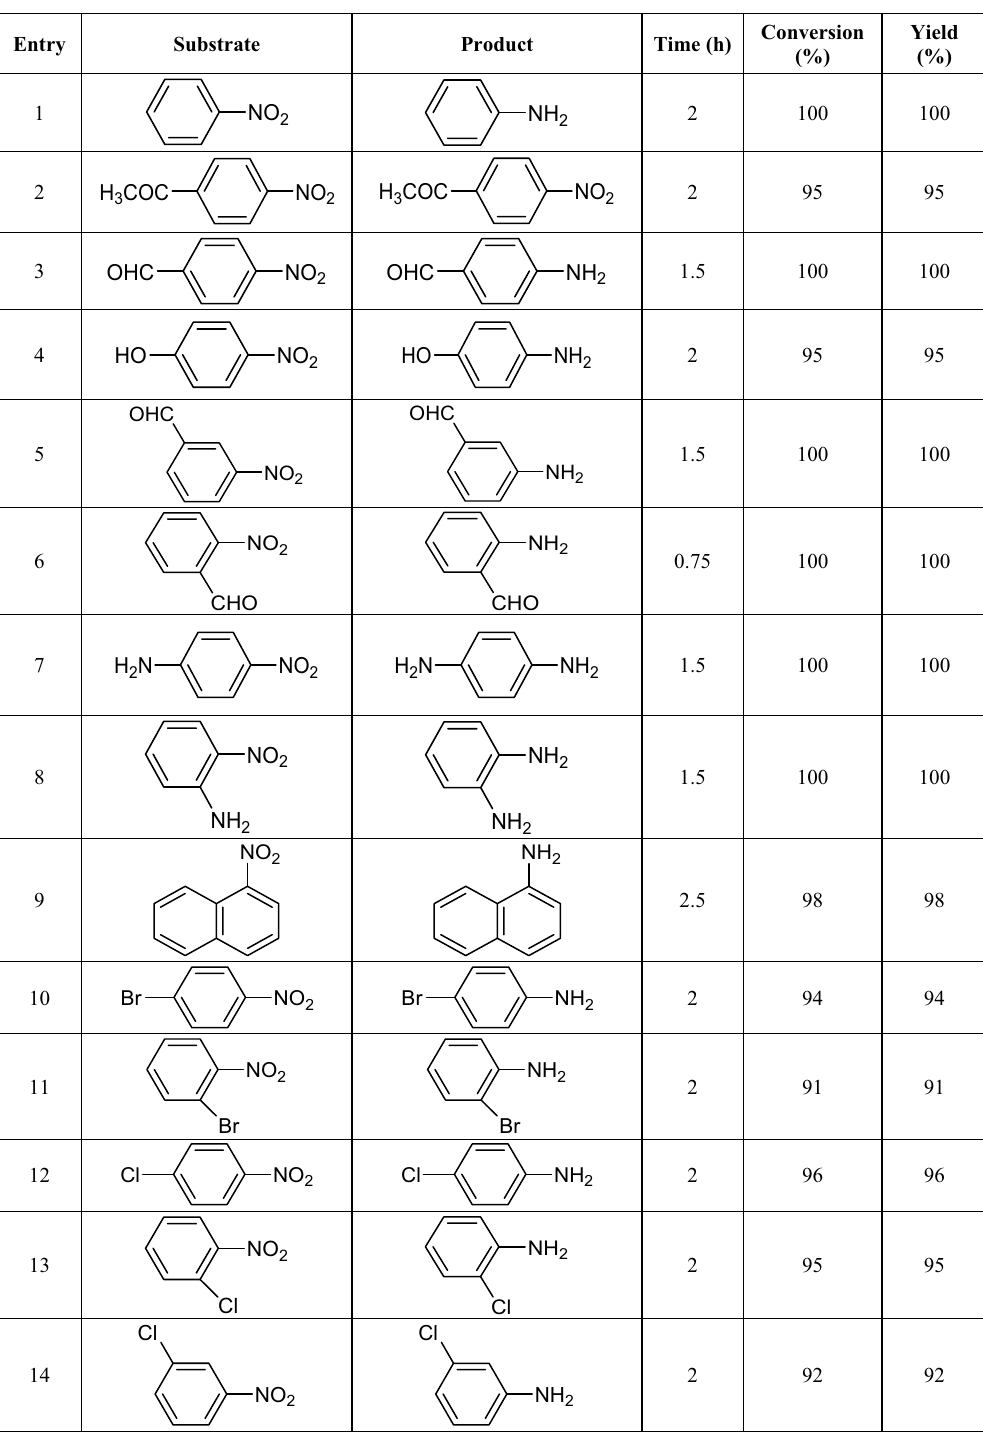
Table 2. Hydrogenation reaction of various nitro aromatic substrates catalyzed by Pd/B-CP-HIm a . a